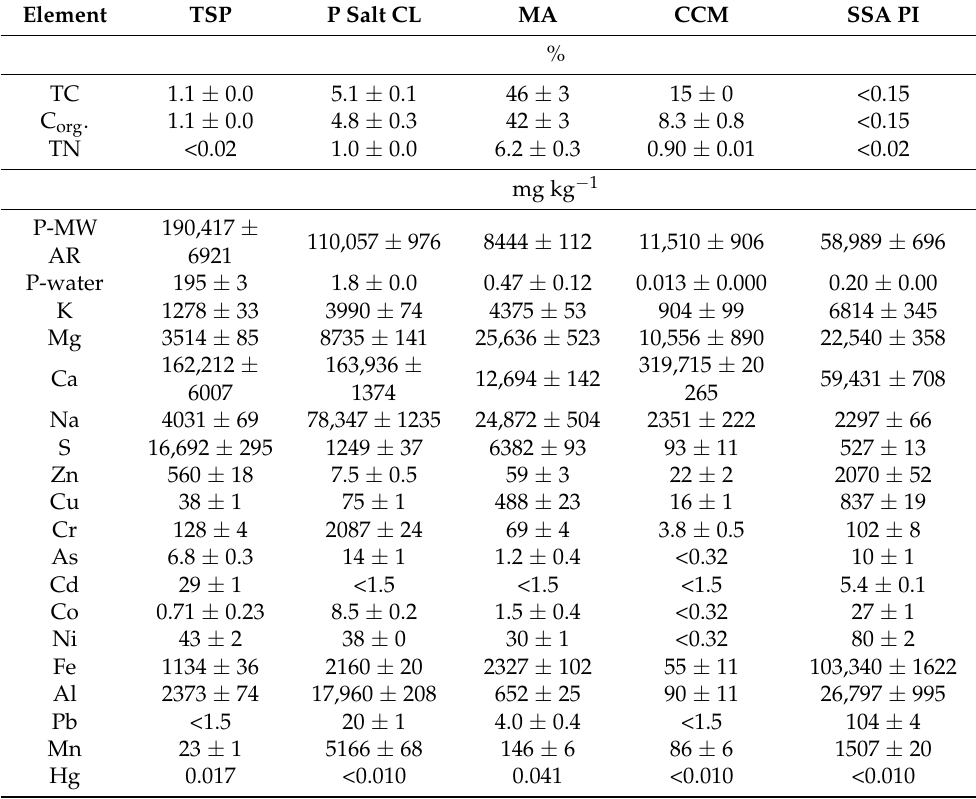
Table 1. Fertilizing product composition (mean ± standard deviation, n = 4).